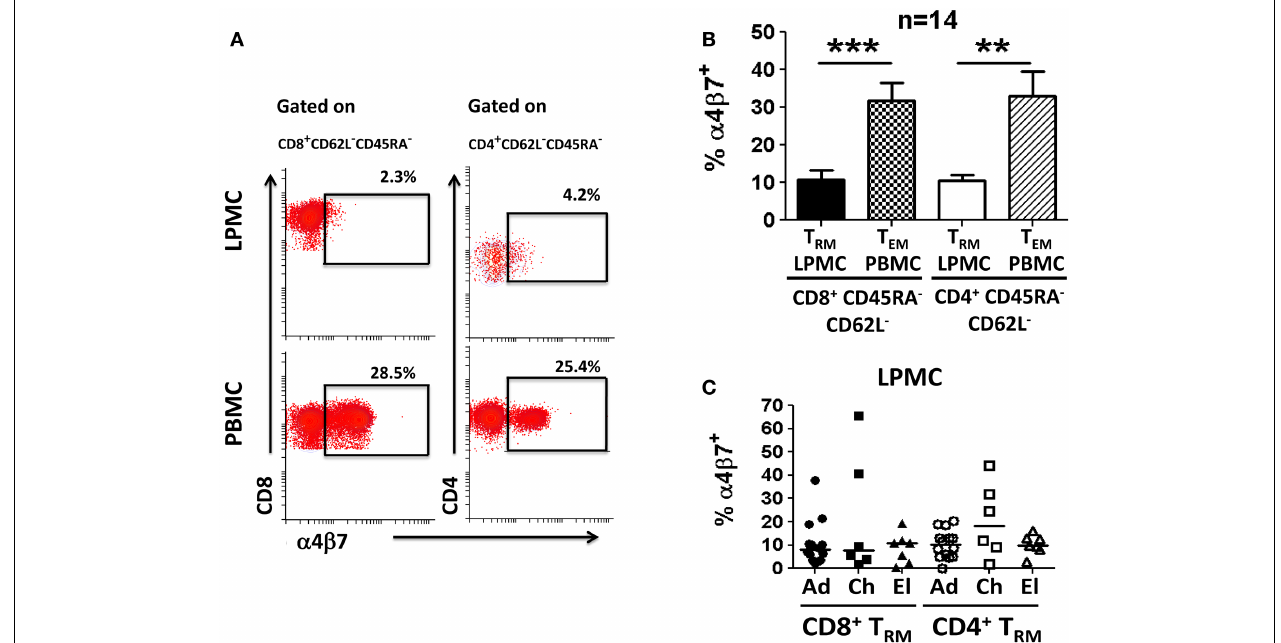
CD4 + T EM (PBMC) cells expressing integrin α 4 β 7. Significant differences are denoted as follows: ** p < 0.005; *** p < 0.0005. (C) Cumulative data comparing the percentage of CD8 + or CD4 + T RM subsets (LPMC) expressing integrin α 4 β 7 by age group. Closed and open symbols represent CD8 + and CD4 + T RM cells, respectively: adults (Ad); children (Ch); elderly